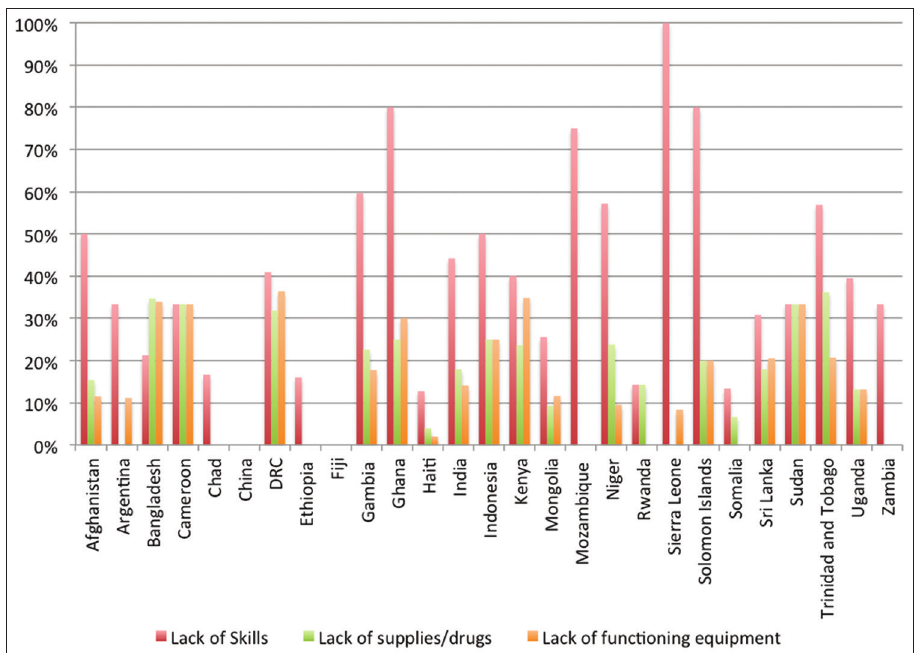
Figure 2: Breakdown of The Driver for Lack of CTEV Treatment by Country Table 3: Multivariate linear regression